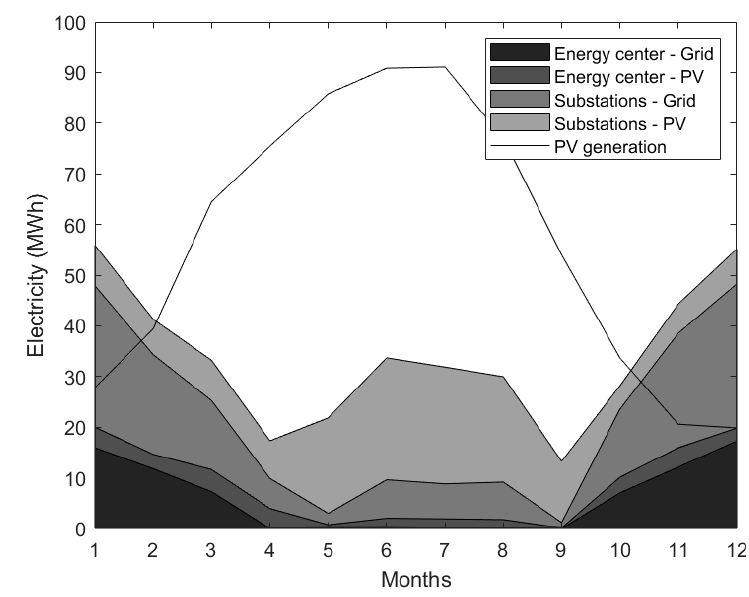
Energies 2023 , 16 , x FOR PEER REVIEW 17 of 32